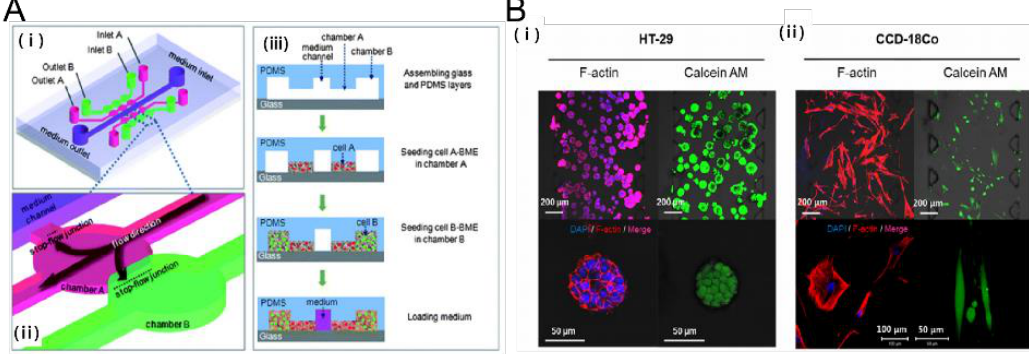
Figure 2. Tumor-stromal interactions on a chip. ( A ) 3D Microfluidic model to investigate the carcinoma associated fibroblast promoted tumor spheroid invasion. (i, ii) microfluidic chip design (iii) cell loading step. Salivary gland adenoid cystic carcinoma cell line (ACC-M) were co cultured with carcinoma associated fibroblasts (CAFs). ACC-M invaded CAF-embedded matrix in a spheroid fashion. However, ACC-M cells did not invade the adjacent matrix when co-cultured with the fibroblast cell line (HFL1) [21]; ( B ) 3D culture of tumor spheroids and fibroblasts in a compartmentalized microfluidic chip. (i, ii) Fluorescence images of HT-29 tumor spheroids and CCD-18Co human normal fibroblast cell line. HT-29 spheroids and CCD-18Co cells proliferated within the space of the corresponding channels over 5 days, during which their growth and interaction were monitored and characterized [26]. Reproduced with permission.